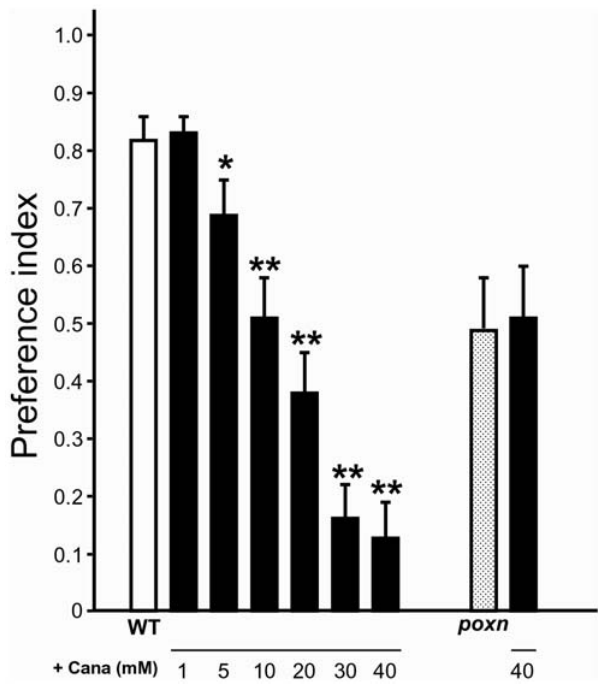
Figure 2. L -Canavanine triggers a chemosensory repulsive effect. Two-choice feeding tests allowed the measure of the preference between the blue and the red solutions of wild-type (WT) and chemosensory defective pox-neuro ( poxn ) mutant flies. A preference index (PI) value of 1 or 0 indicates a complete preference or aversion for the blue solution, respectively. A value of 0.5 indicates no preference. See Materials and Methods for the calculation of the PI. In our conditions, WT flies prefer the blue solution (white). When L -canavanine (Cana, black) was added at the indicated concentration (1 to 40 mM), it inhibited the intake of the blue solution in a concentration-dependent manner, being very aversive at 30–40 mM. In contrast, poxn flies fed equally on the blue solution with (black) or without (dotted) 40 mM L - canavanine, indicating a chemosensory action for the plant amino acid. Error bars indicate SEM. The single and double asterisks indicate significant differences by t -test ( p , 0.05 and p , 0.001, respectively) between WT flies that fed on the blue solution without (white) or with (black) L -canavanine.